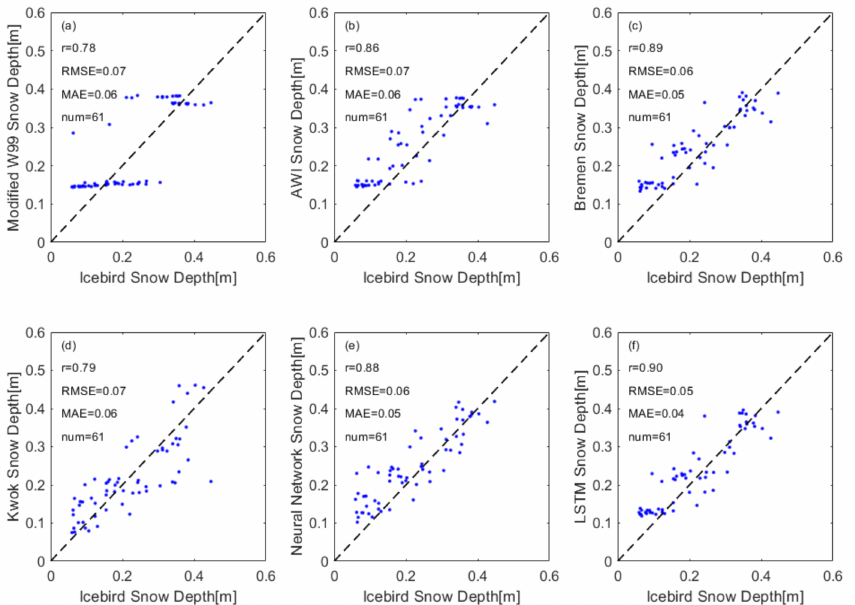
Figure 10. Scatterplots of different snow depth products and IceBird snow depth: ( a ) modified W99 snow depth, ( b ) AWI snow depth, ( c ) Bremen snow depth, ( d ) Kwok snow depth, ( e ) Neural Network snow depth, ( f ) LSTM snow depth. The black line is the relationship with each